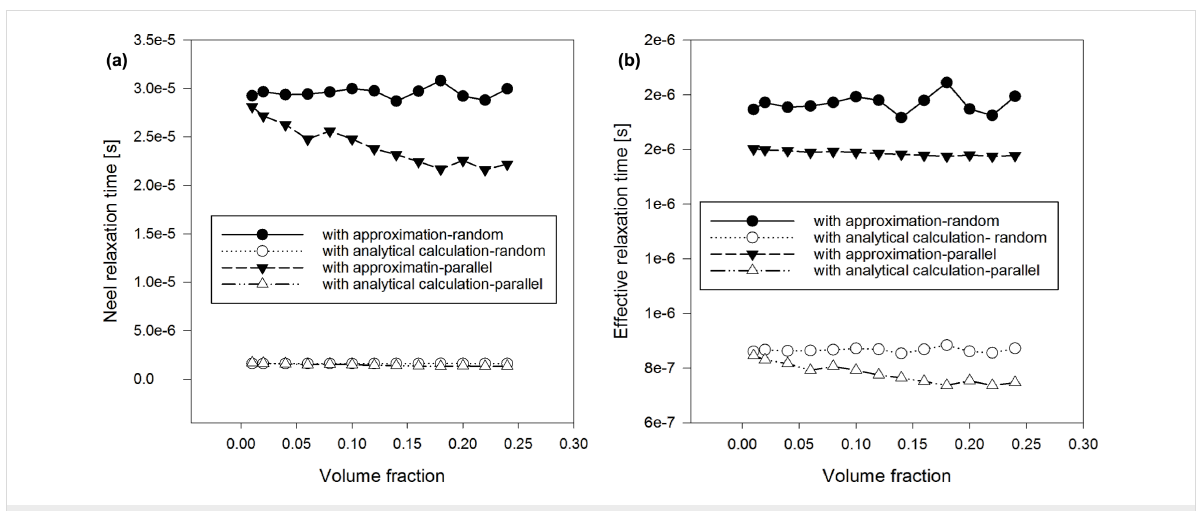
Figure 2: (a) Néel relaxation time and (b) effective relaxation time vs volume fraction of nanoparticles with diameter 17 nm.